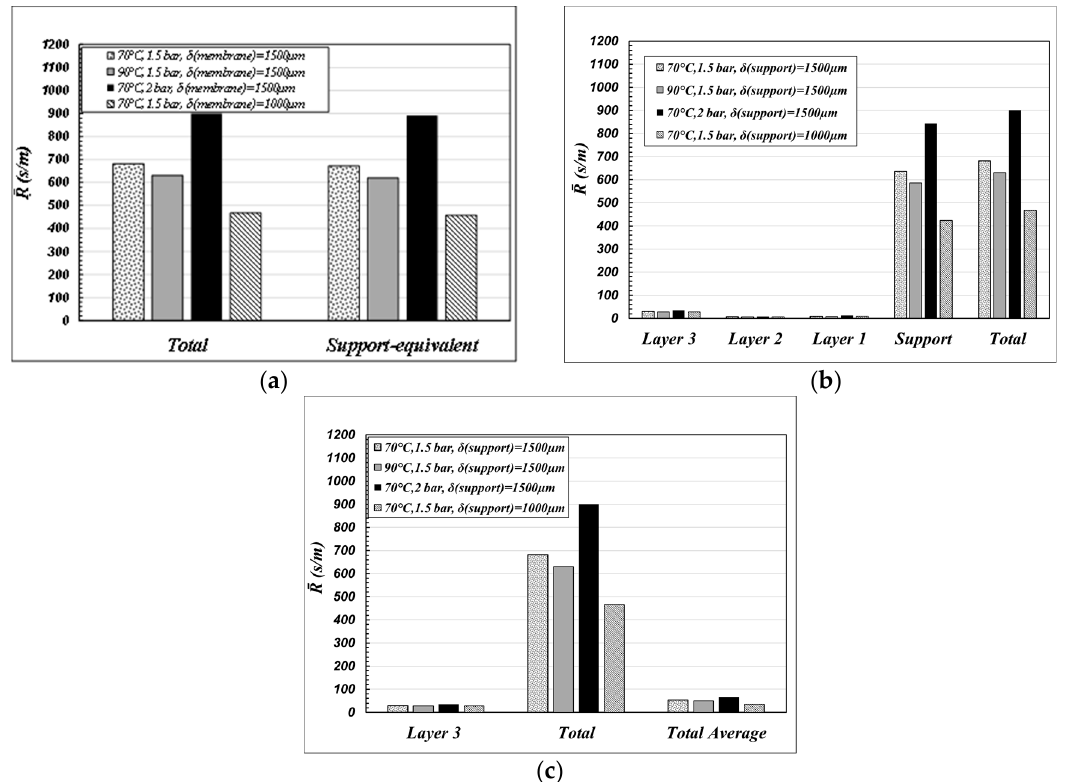
Figure 5. Mass transfer resistance of water vapor in air across each layer of a coated single channel (Equation (9)). Comparison among different calculation methods at various operative conditions and different support thicknesses (parameters from Table 1). ( a ) Resistance of each single layer and their sum resulting in total membrane resistance indicated by “Total ”. ( b ) Membrane resistance on considering the contributions of the four layers indicated by “Total” and the resistance on regarding the membrane composed of a single layer having the morphological properties of the support layer indicated by “Support-equivalent”. ( c ) Resistance of layer 3, resistance of the membrane on considering the contributions of the four layers indicated by “Total” and the resistance of the membrane on considering average morphological values of the whole membrane (Table 1—case (c)) indicated by “ Total Average ”